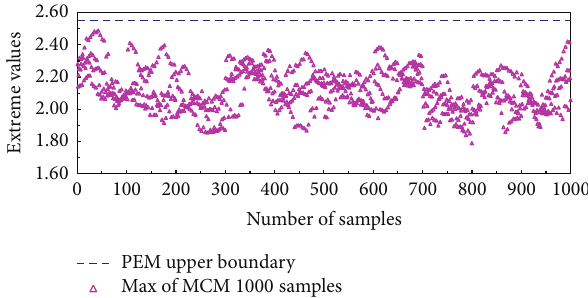
Figure 15: Comparison of Sperling’s ride index of motor car.